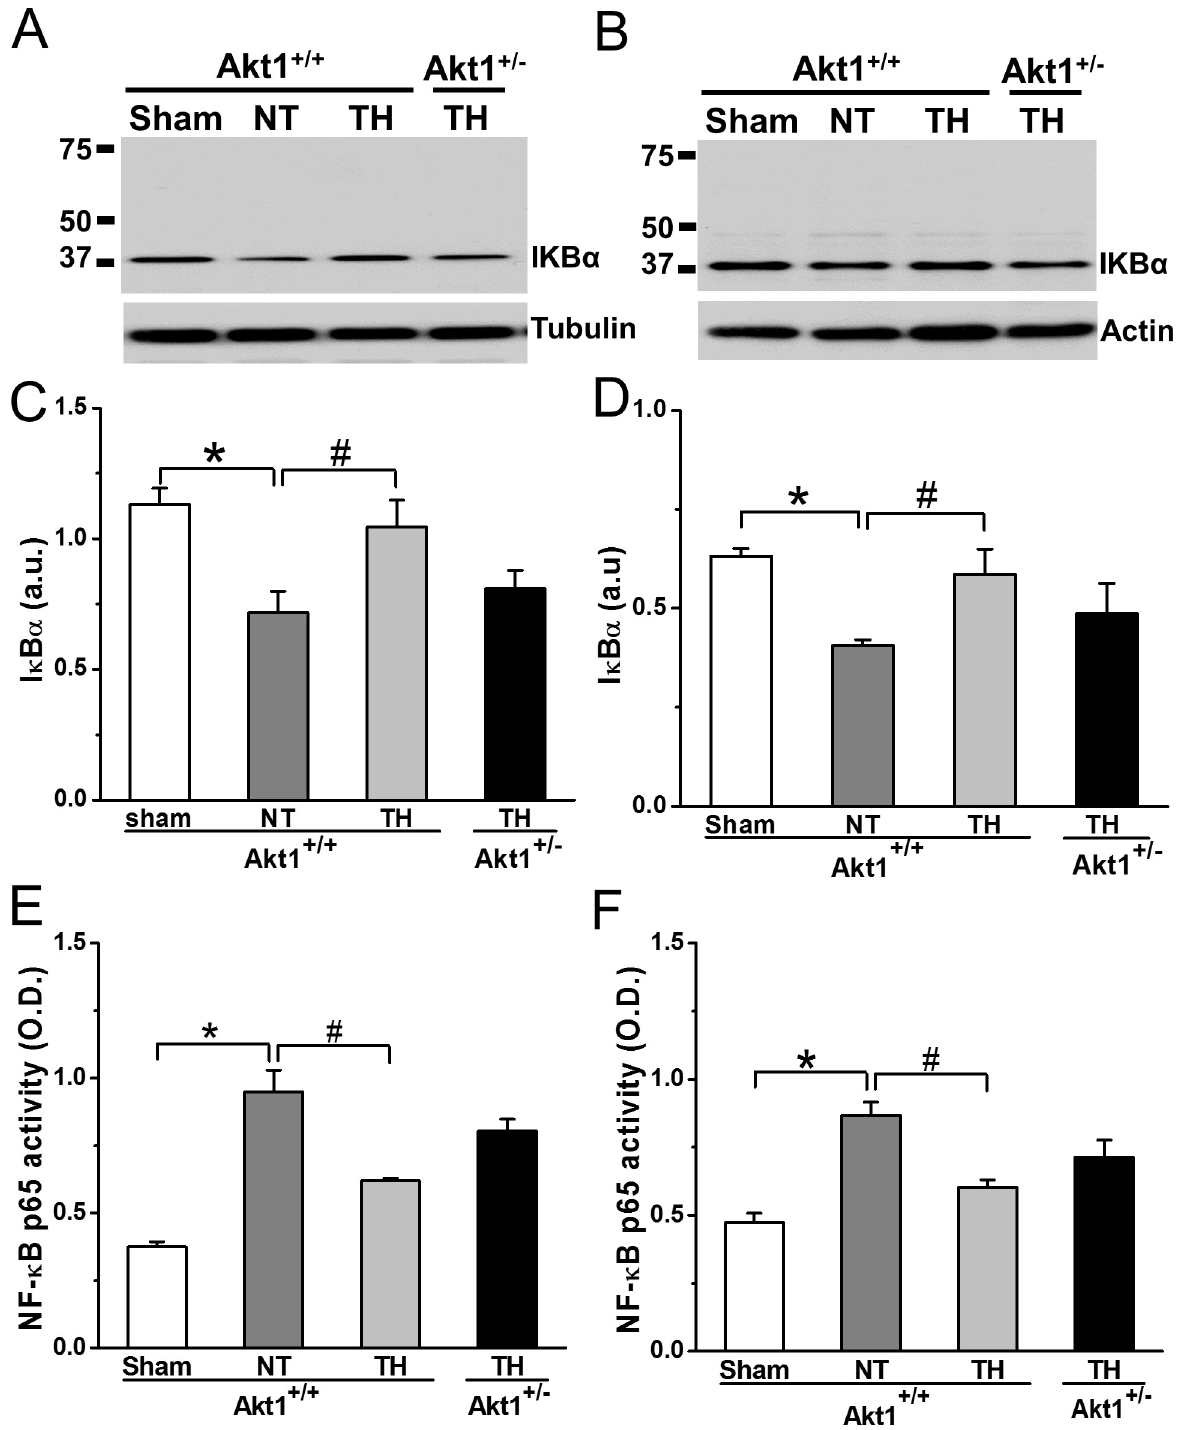
Fig 6. I κ B α degradation and NF- κ B activity at R30 in heart and brain of Akt1 +/+ and Akt1 +/- with TH treatment. A , C : I κ B α and NF- κ B at R30 in heart. α -tubulin was used as loading controls for heart. B , D : I κ B α and NF- κ B at R30 in brain. β -actin was used as loading controls for brain. � p < 0.05 between sham and NT groups of Akt1 +/+ mice; # p < 0.05 between NT and TH groups of Akt1 +/+ mice. Data presented are means ± SEM of five